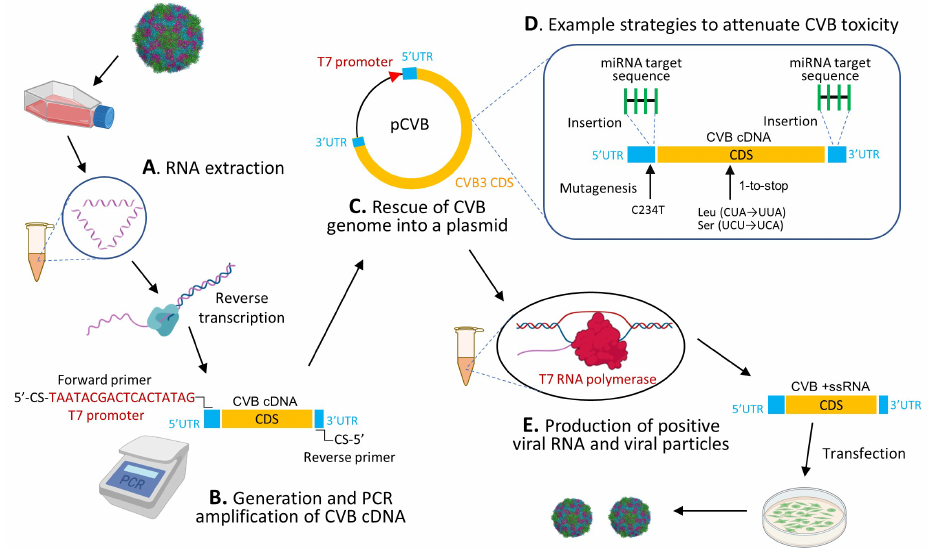
Figure 4. Schematic illustration of the strategy for generating a non-toxic CVB for oncolytic purpose. ( A ) Viral RNA